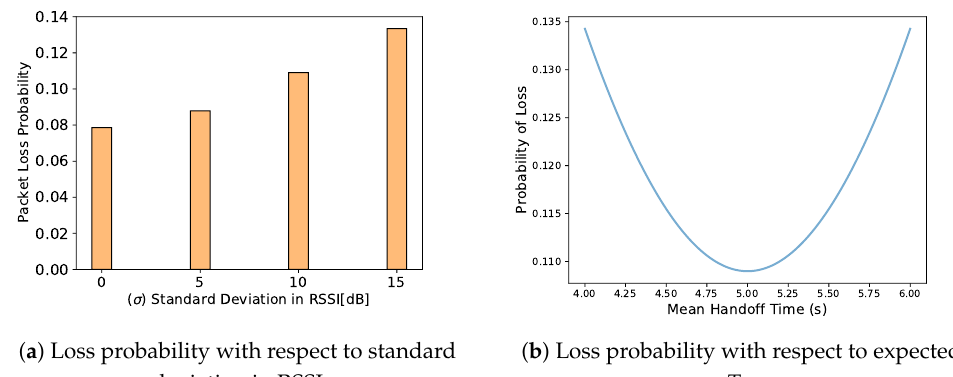
Figure 7. As illustrated in ( a ) with a higher variance of RSSI, it is expected to experience more packet loss in the system as the links are less stable. In ( b ), the packet loss probability with respect to the expected time for receiving the route-injection packet or T rx (or Mean handoff time) is illustrated. The minimum packet loss happens when the packet is expected to be received in the middle of the trajectory (t = 5 for the scenario with 10 m distance).